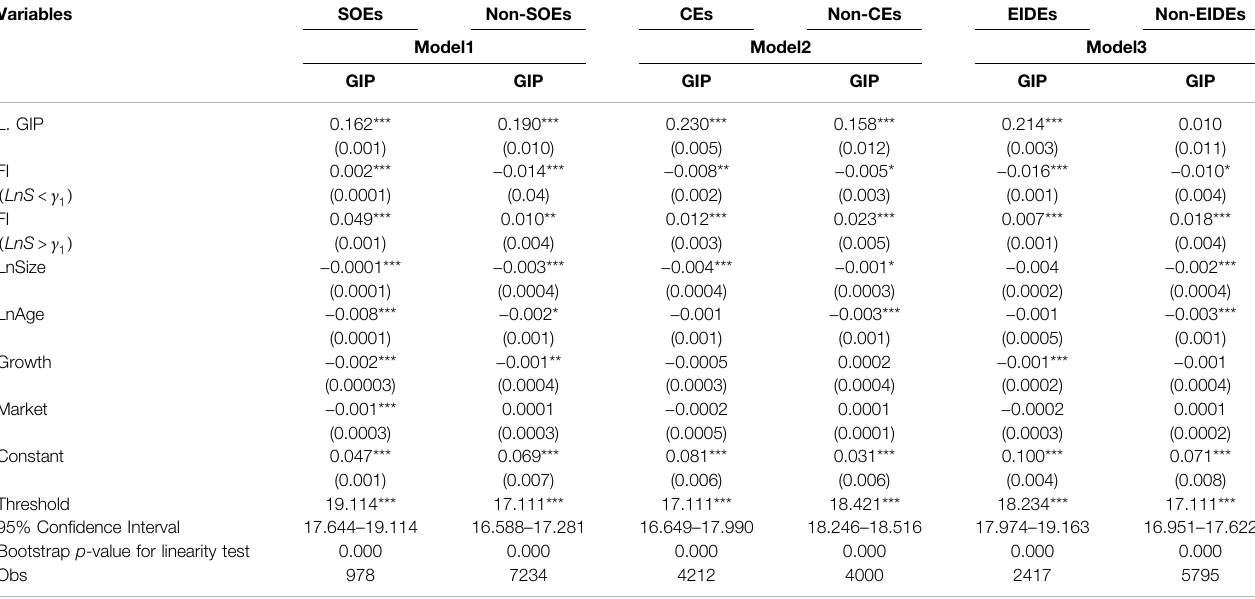
TABLE 6 | Regression of Heterogeneity analysis-based on the dynamic panel threshold effect. Variables